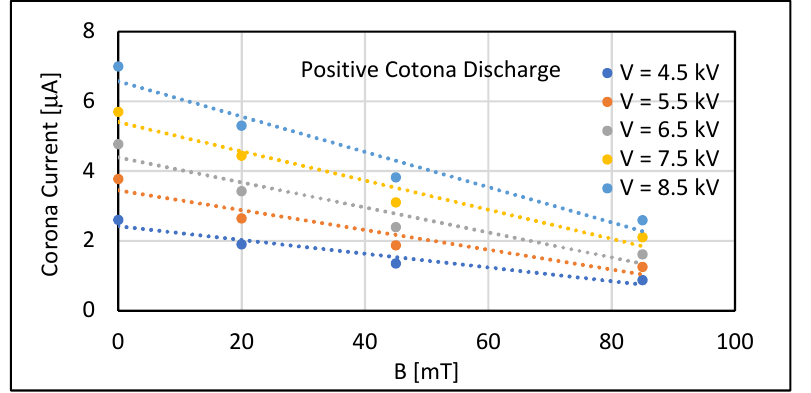
Figure 5. Positive corona currents versus crossed magnetic field B at different values of applied voltage.